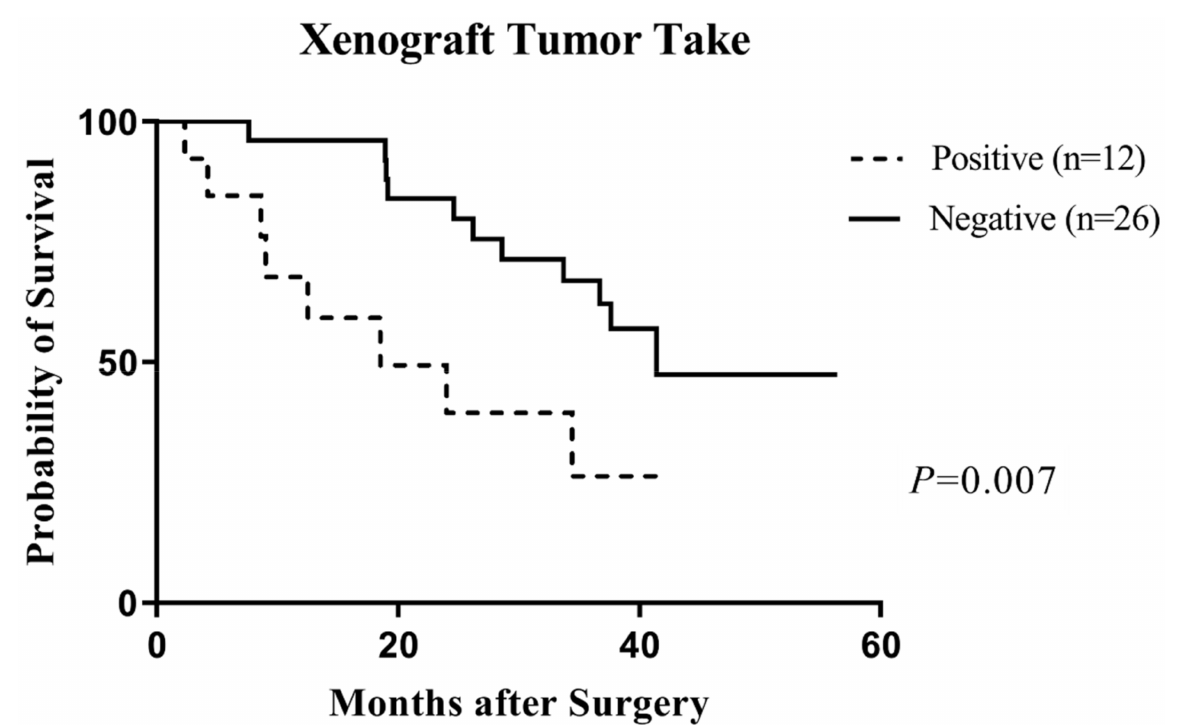
Figure 1. Prognostic value of the in vivo tumor take on the progression-free survival (PFS) of corresponding chordoma patients (univariate analysis). The PFS was significantly lower for patients whose tumors were able to grow into nude mice compared to patients whose tumors did not grow after in vivo transplantation (Wilcoxon test, p =